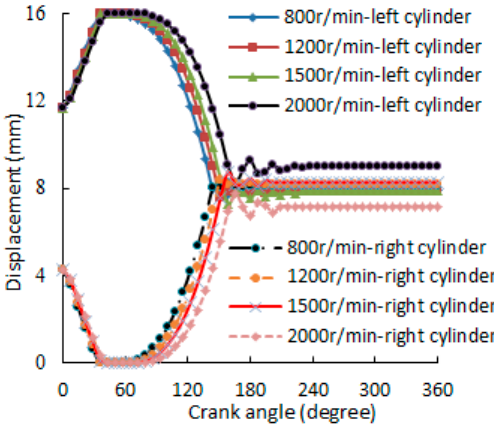
Figure 6. Displacement of the cylinder piston at different engine speeds with the same adjustment quantity.